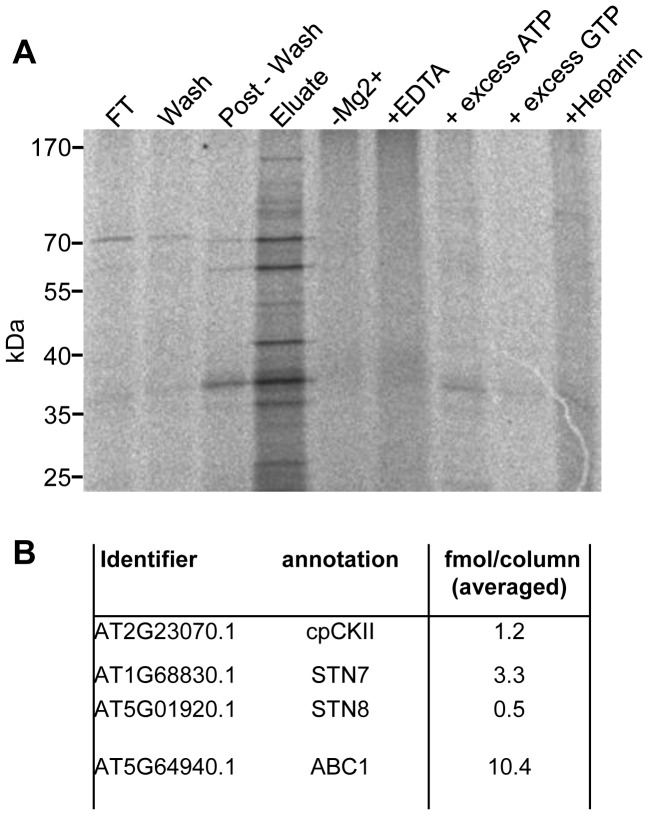

In vitro phosphorylation activity of native pCKII preparations.(A) Autoradiography result of an activity assay with native pCKII isolated from Arabidopsis chloroplasts by Heparin-Sepharose chromatography with dephosphorylated and heat inactivated stroma proteins as substrates. Lanes 1–4 show the different chromatography fractions: flow through (FT), wash, post-wash and eluate. Lanes 5–9 present controls with the kinase active eluate fraction. Control reactions contained, no MgCl2, 1 mM GTP, 15 µg/ml heparin, 1 mM ATP and 5 mM EDTA where indicated. (B) Concentration of kinases in the active Heparin-Sepharose fractions determined by triplicate HD-MSE detection (see Materials and Methods and Table S4 in File S1 for further details).